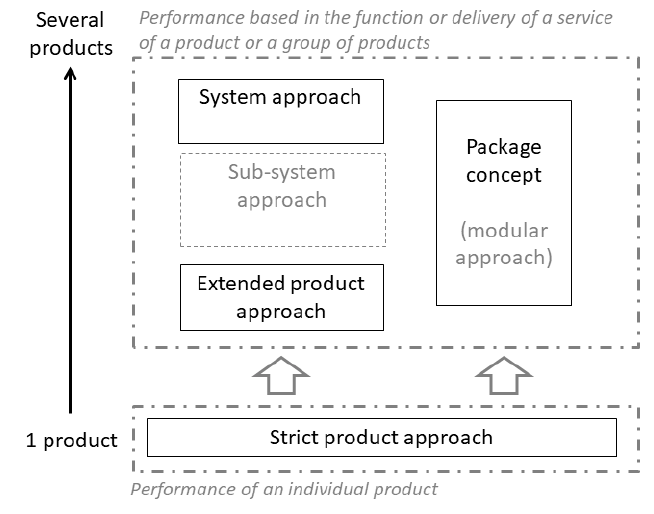
Figure 1. Schematic positioning of the different approaches of EU product policies in terms of the complexity of the system of products considered.